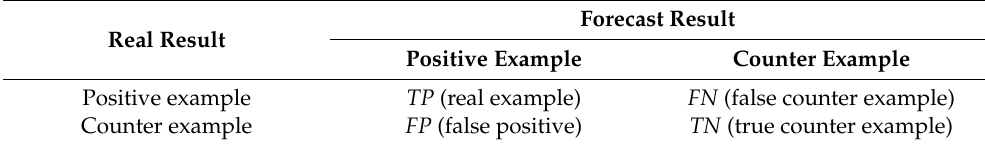
Table 5. Confusion matrix for binary classification